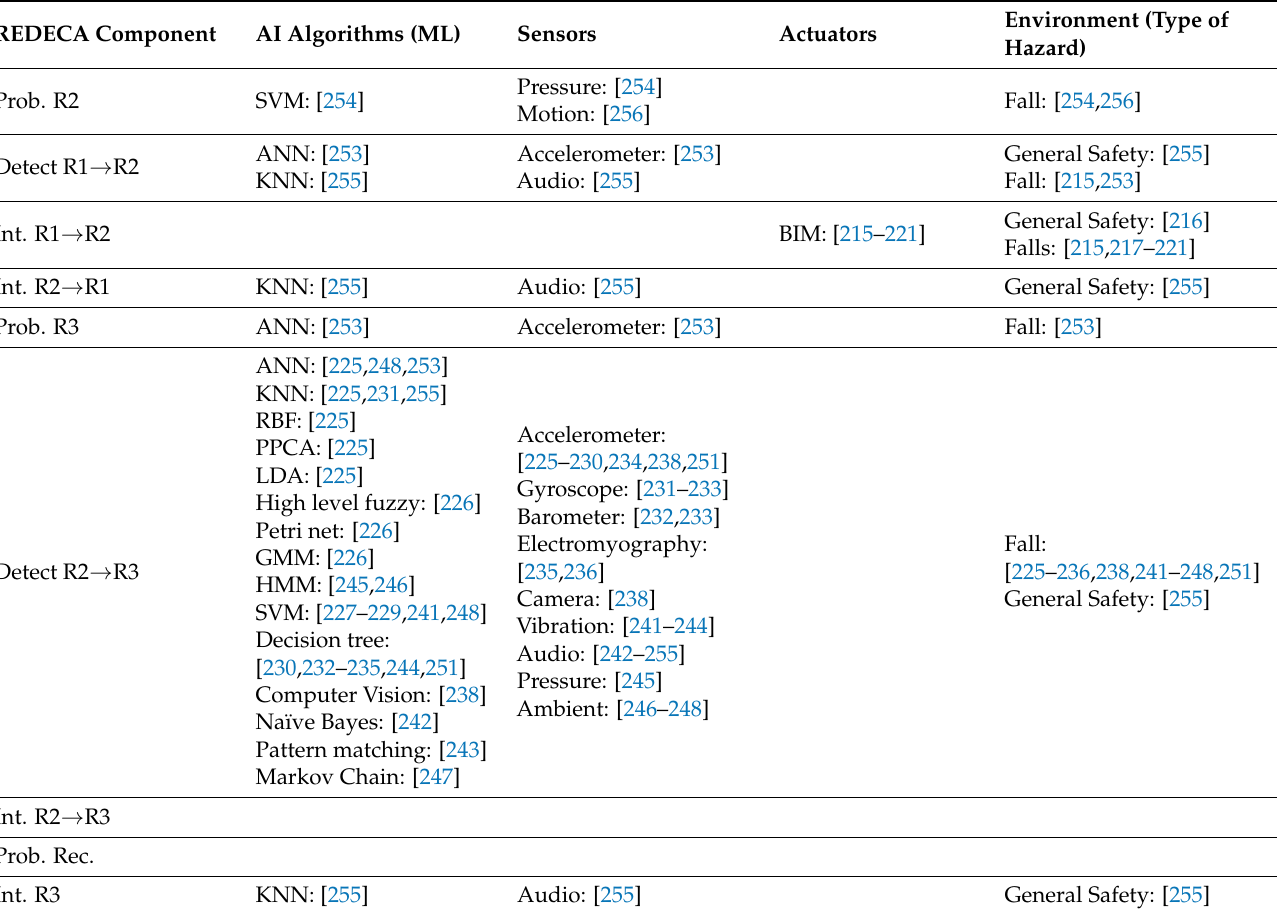
Table 8. Construction AI/OSH algorithm, sensor and actuator research organized by the REDECA framework. Major technologies described by each paper is mentioned and linked to the relevant papers [211–256]. Summary of each paper is found in Appendix